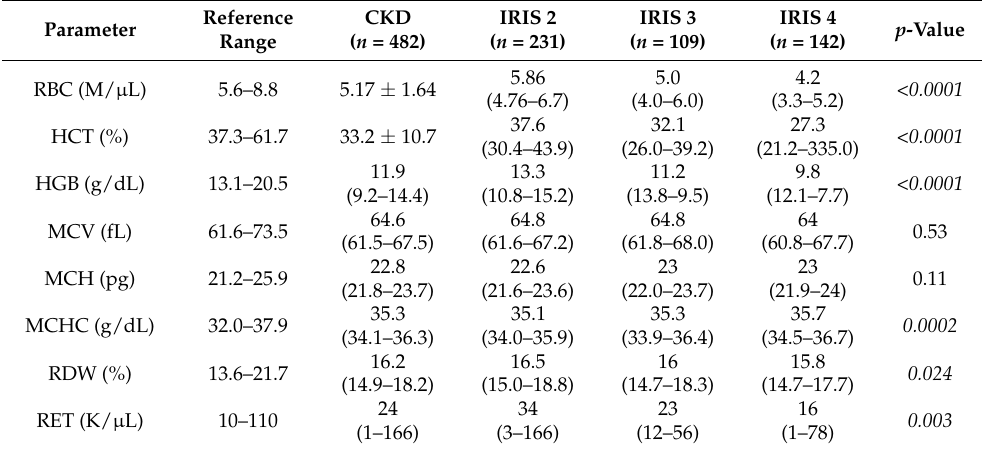
Table 3. Kruskal-Wallis comparison of erythrogram parameters of dogs at different IRIS stages.